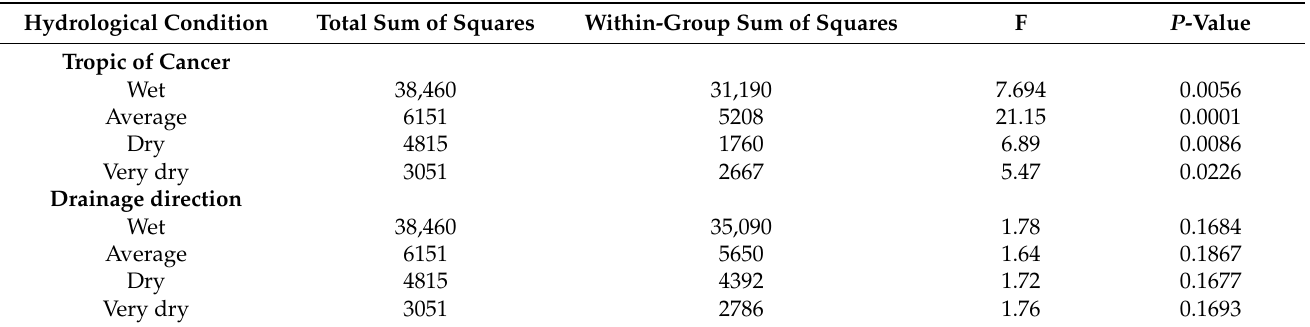
Table A3. Effects of response variables (wet, average, dry, and very dry conditions) between river type and variability groups (inter-annual, dry, and wet season) (one-way PERMANOVA). Euclidean similarity index, permutation 9999 times.